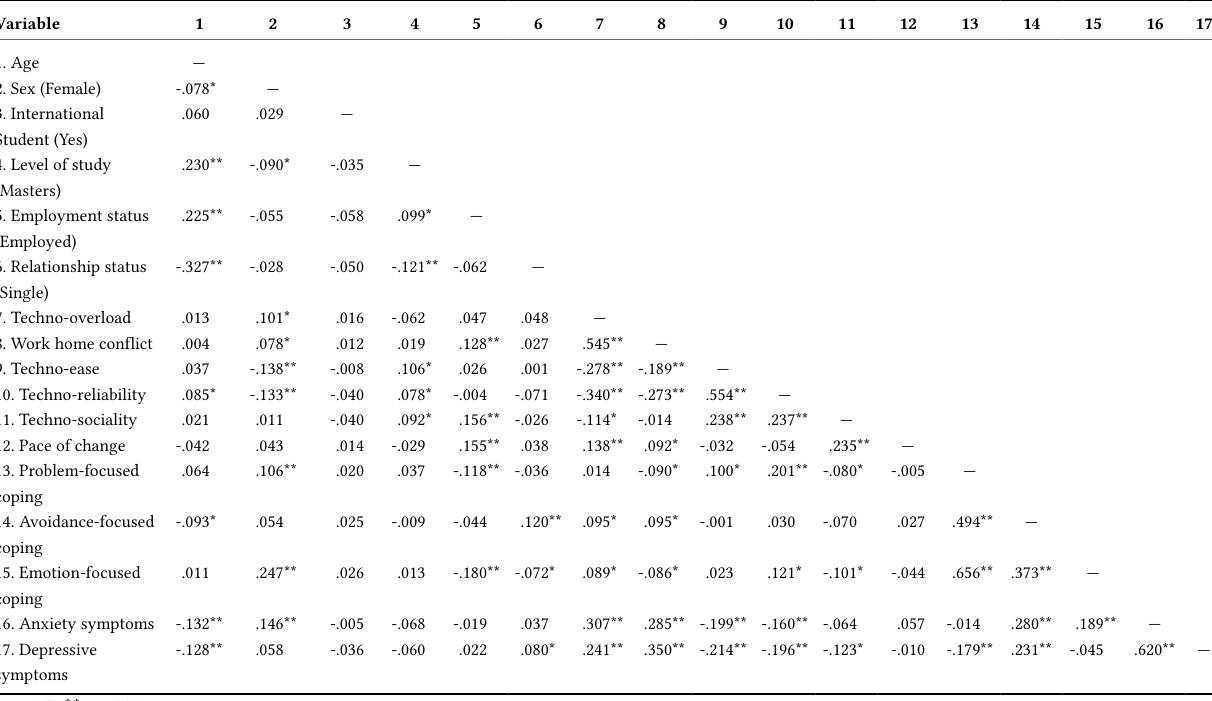
Pearson’s Correlations Between Study